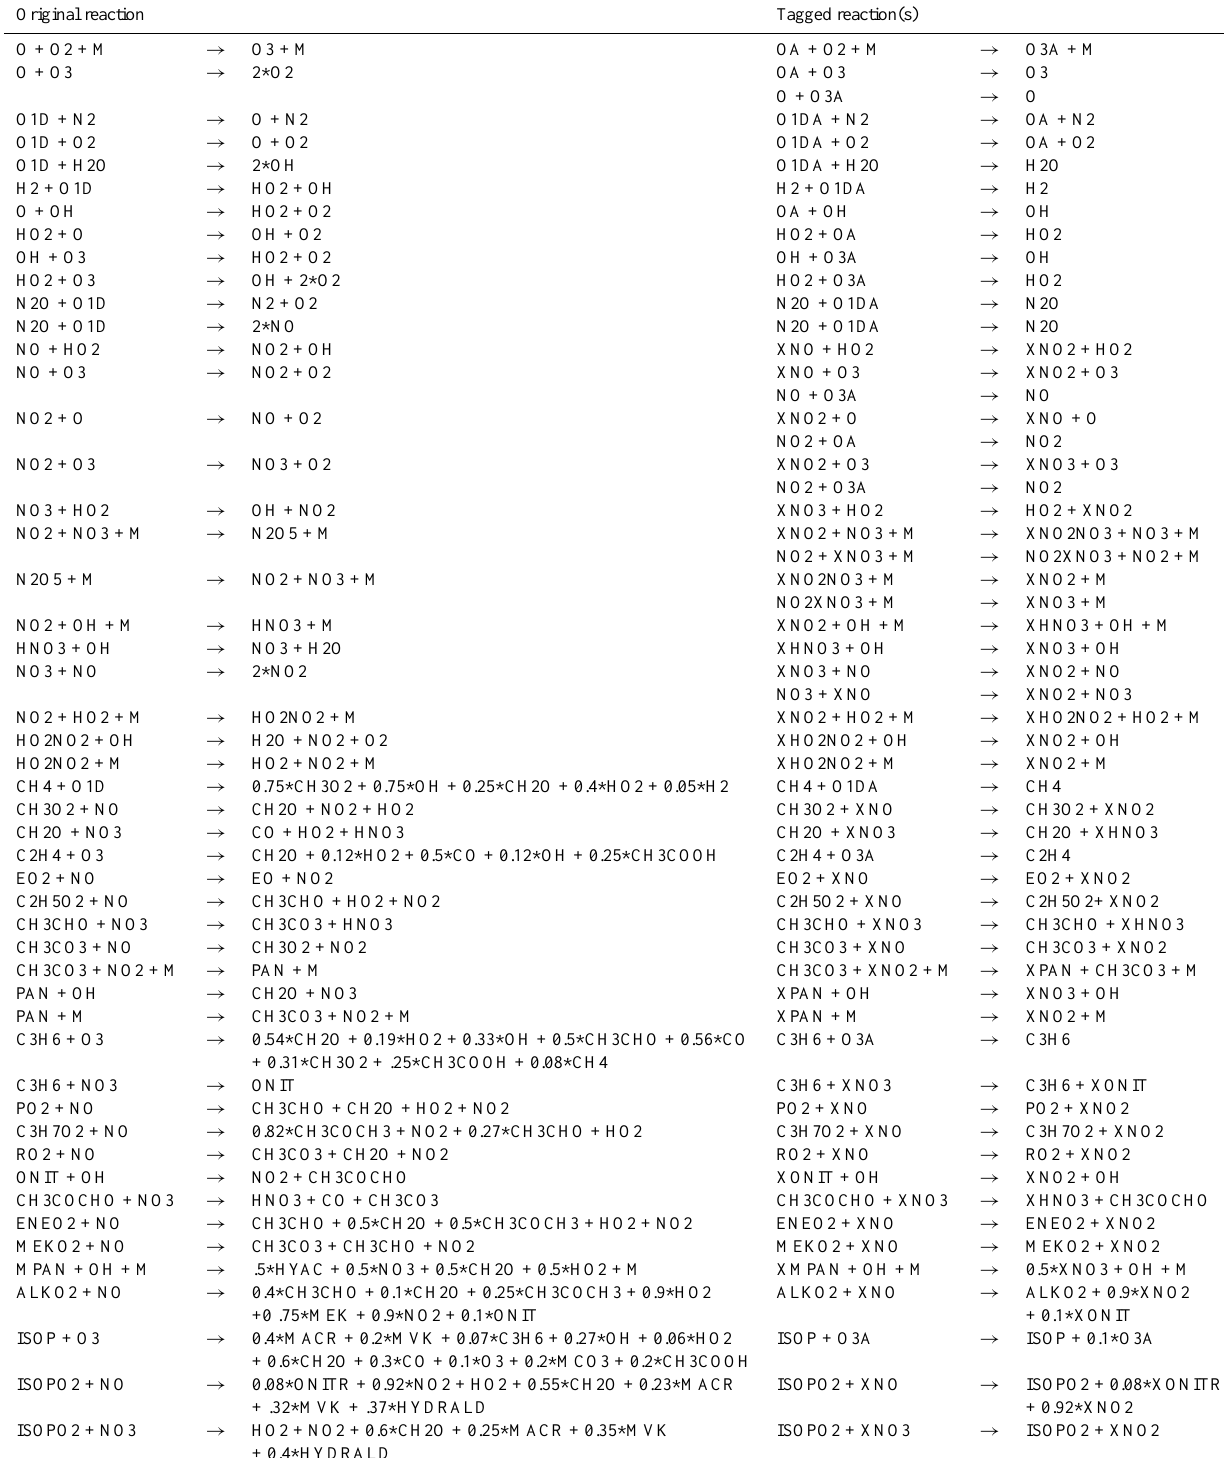
Table 3. Gas-phase reactions of tagged